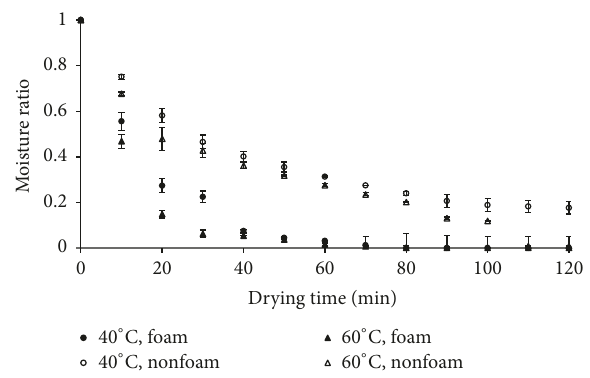
Figure2:Moistureratiooffoamandnonfoamroselleextractdrying at different air temperatures.